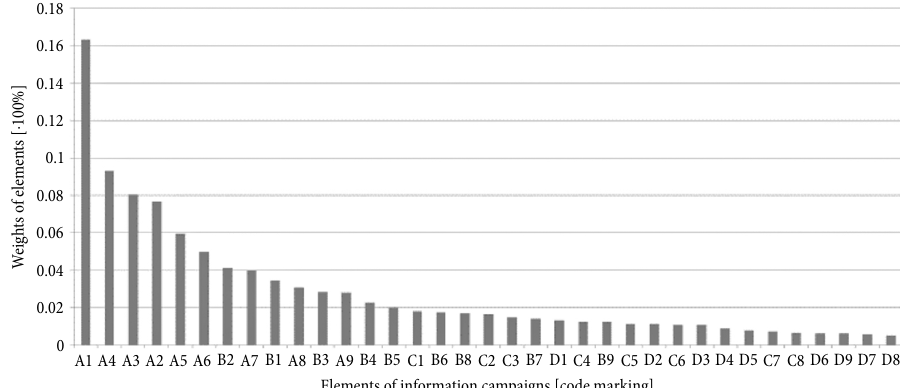
Fig. 2. Weights of importance reached in the way of Saaty’s Method (two-level consideration)